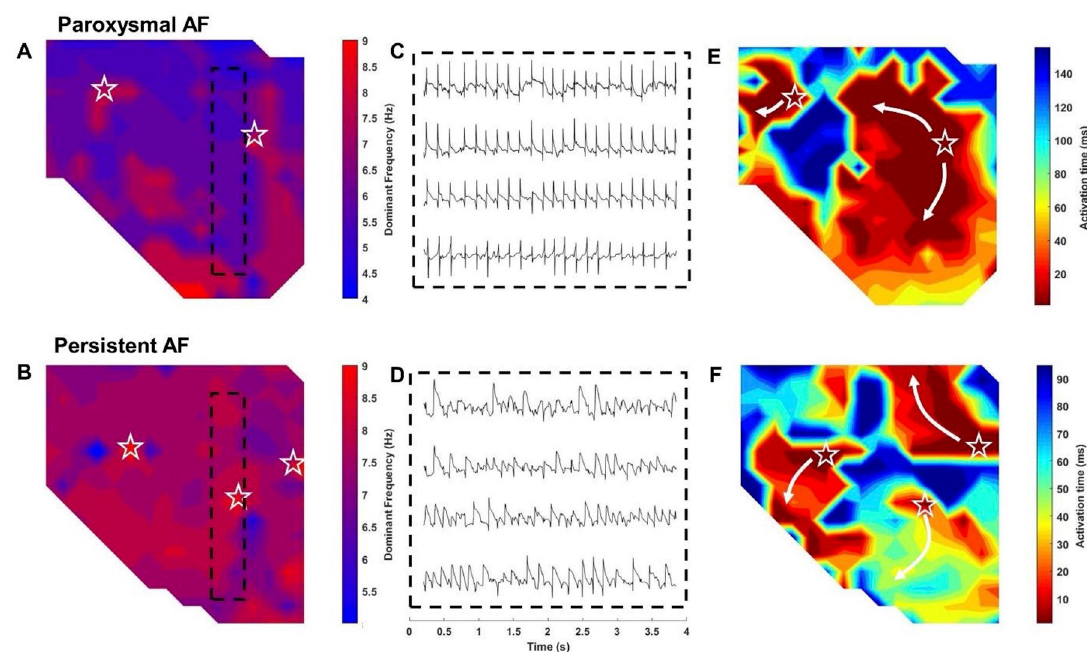
Fig 3. High resolution spatial mapping of dominant frequency. Two-dimensional spatial mapping of DF identified areas of higher DF (in red) and lower DF (in blue). The (A) paroxysmal AF left atrium had a larger distribution of low-DF (blue) areas, versus (B) persistent AF. (C-D) Representative electrograms for paroxysmal and persistent AF derived from the dashed boxes. (E-F) Corresponding isochrone maps of action potential wave propagation captured multiple sites of action potentials originating from sites of high DF. ( Δ – denotes sites of activation).